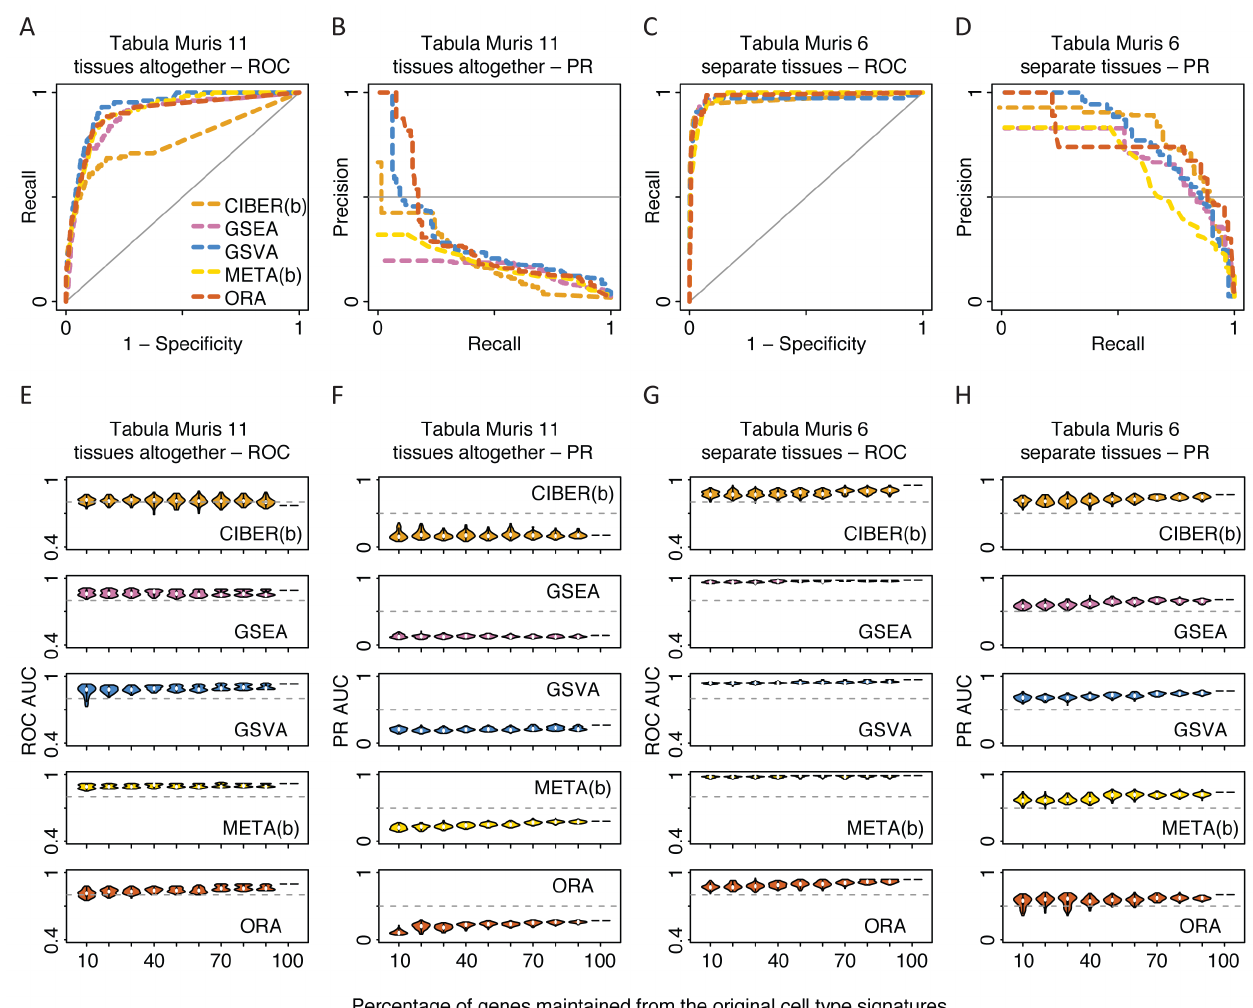
Figure 3. Performance and robustness analysis of cell type prediction methods using Tabula Muris scRNA-seq data. The same procedure as described in Figure 2 for ROC and PR AUCs of the liver and retinal neuron datasets was used here for the Tabula Muris dataset. Please see Figure 2 legend for details. The Tabula Muris dataset was analysed in two ways. In the first way (‘Tabula Muris 11’, panels A , B , E and F ), 11 tissues whose cell type signatures and cell clusters could be mapped against each other were analysed using all cell type signatures as a single input gene set database for cell type prediction methods. In the second way (‘Tabula Muris 6’, panels C , D , G and H ), the analysis was restricted to six tissues with three or more cell type signatures. In this strategy, each tissue’s cell types were